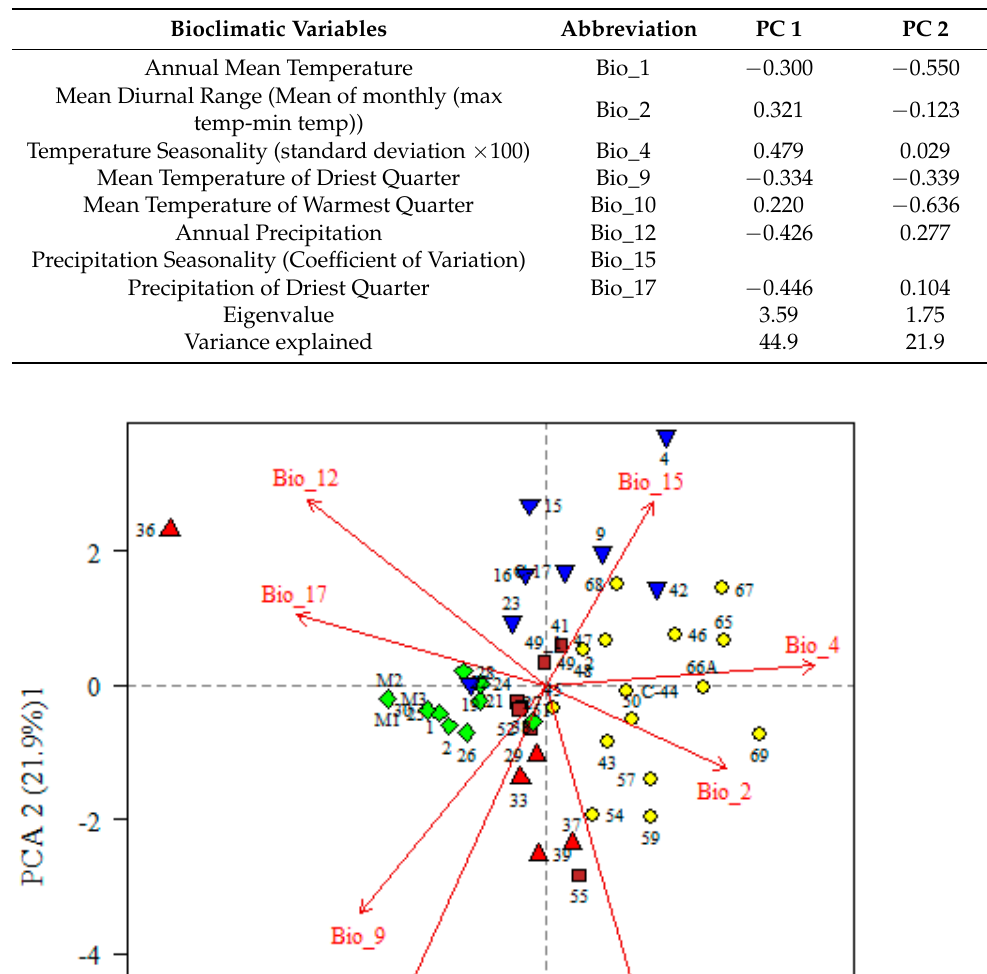
Table 2. The eigenvector values between climatic variables and the first two major components, with eigenvalues and the explained variation.